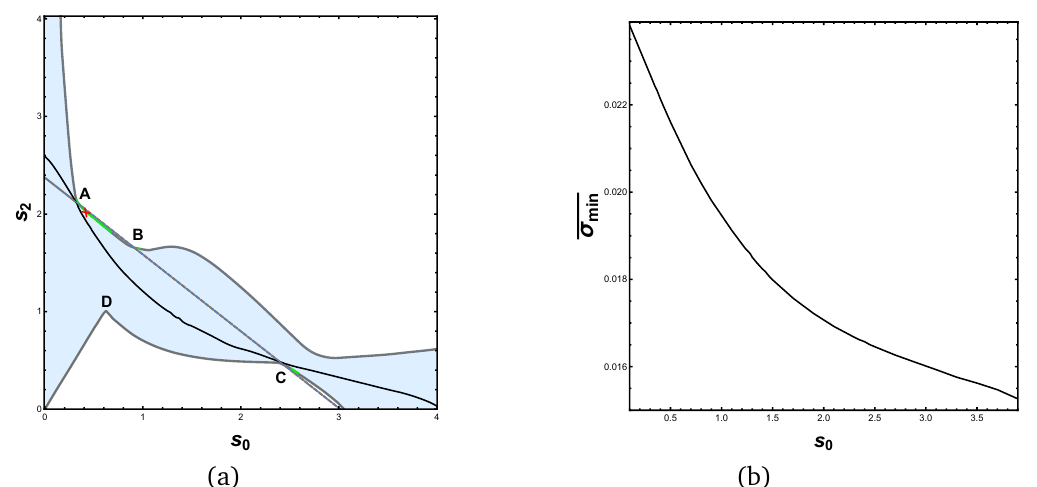
Figure 5: (a) The black curve within the river river gives the s 2 with minimum average cross section for each s 0 . Note that the curve passes very close to regions A and C described earlier (b) The value of the corresponding minimum as a function of s 0 for N max = 14 and L max = 19. The global minimum average cross section appears to be at s 0 =